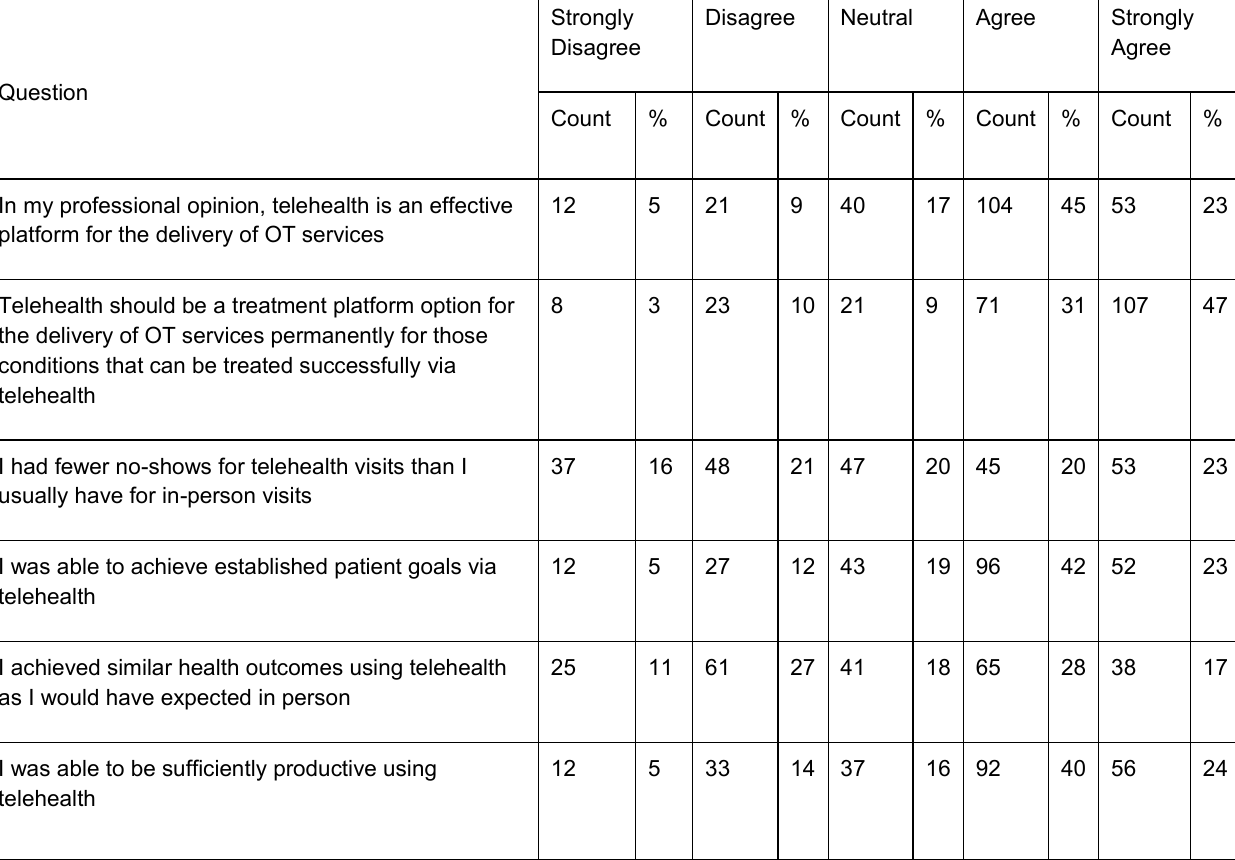
Specific Questions Asked in the Likert Scale Format and Responses